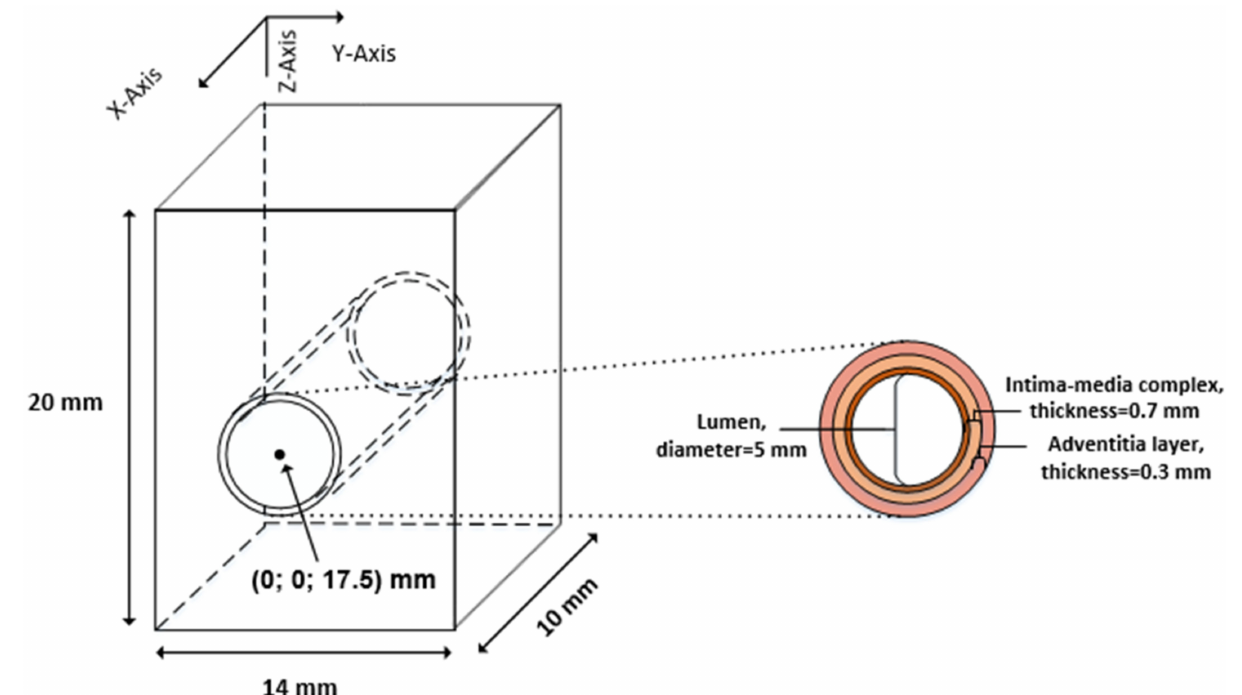
Figure 2. The general geometry of the artery